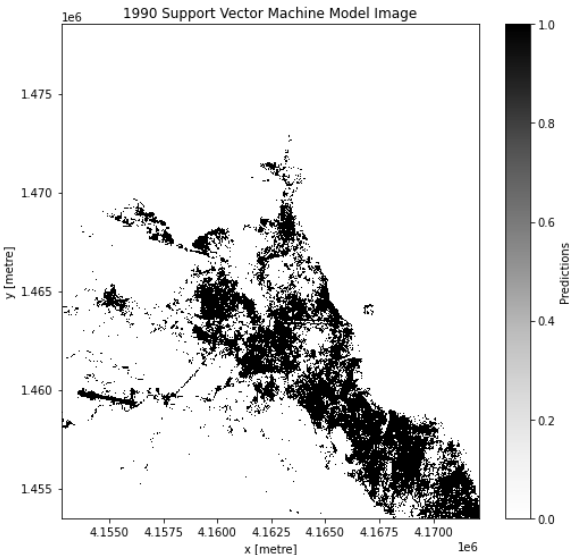
Figure 9. Support vector machine results for 1990.